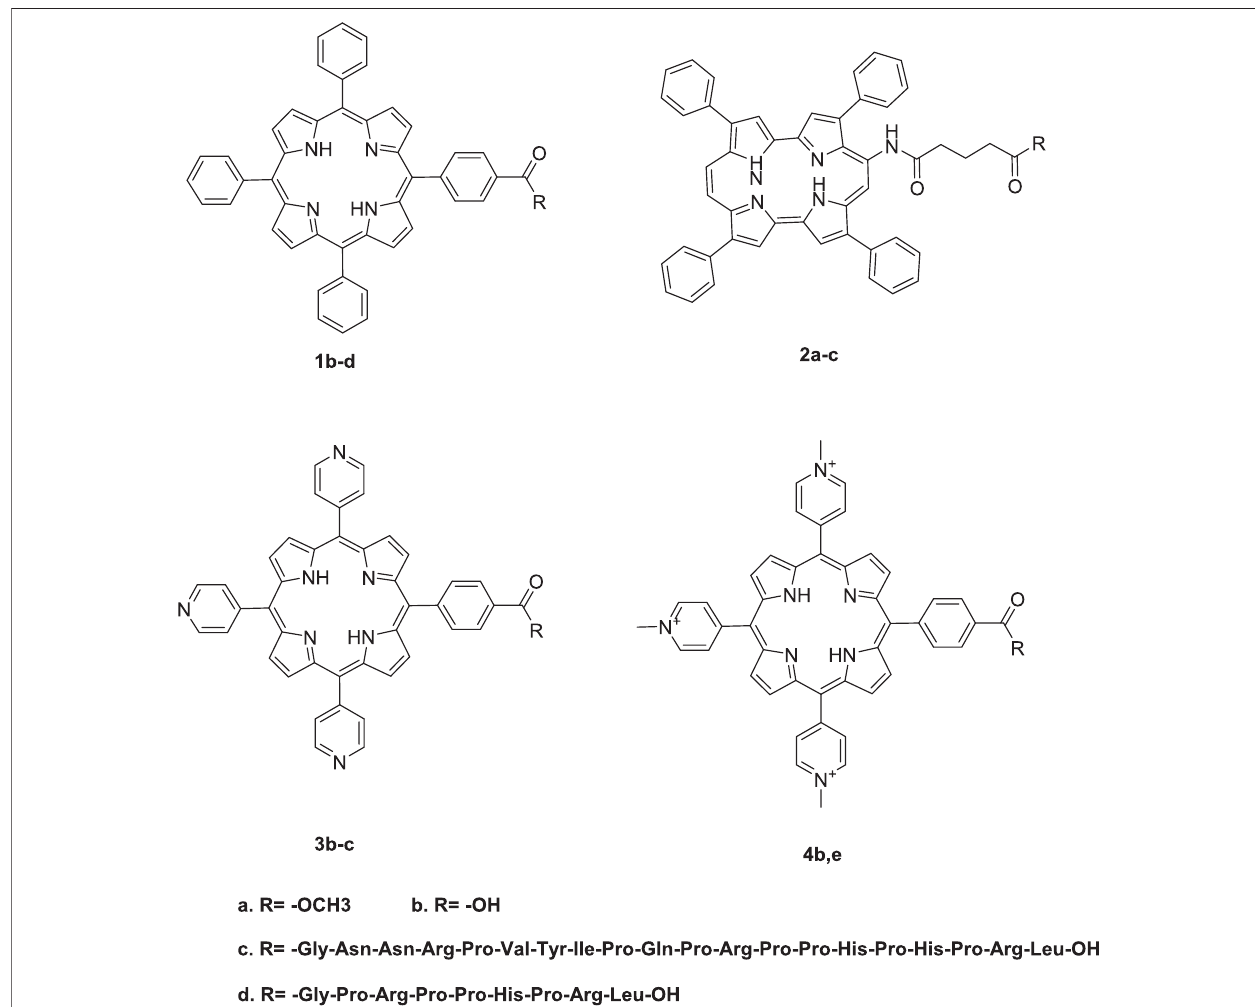
FIGURE 2 | Conjugates obtained from the conjugation of porphyrins with antimicrobial peptides. There was enhanced PACT activity when the conjugates were used. By the use of the amide linkage, different peptides with different amino acid sequences and lengths were couped to the free porphyrins. The hydrophilicity offered by peptides together with the hydrophobicity of the peptides resulted in a conjugate that was amphophilic. The amphiphilicity results in better solubility of the free porphyrins Reproduced with permission from Dosselli et al. (2013).